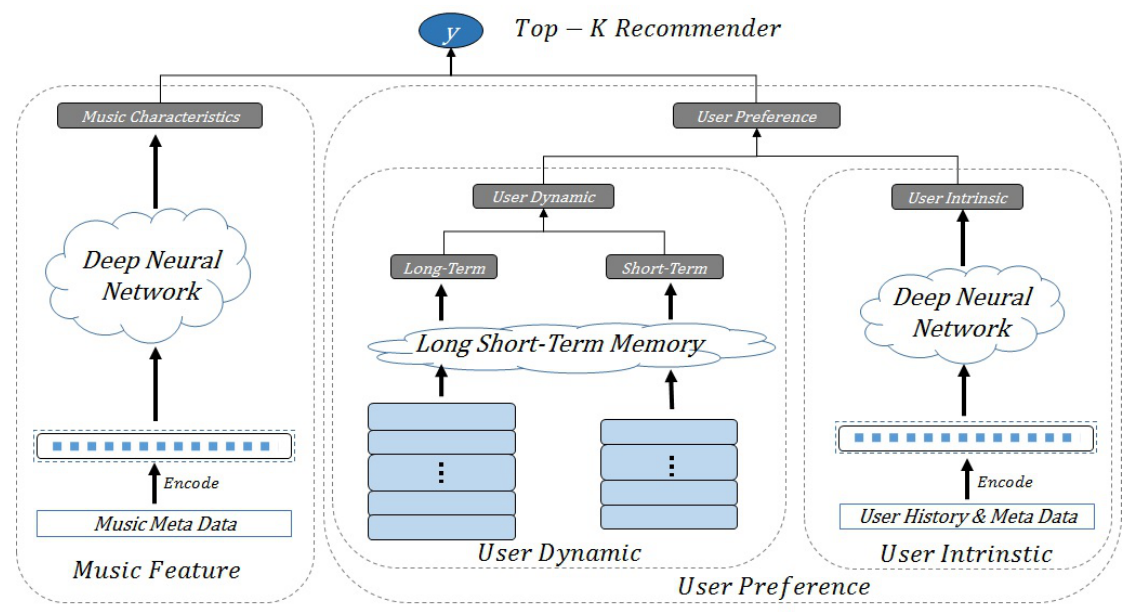
Figure 1. The Deep Temporal Neural Music Recommendation Model (DTNMR).